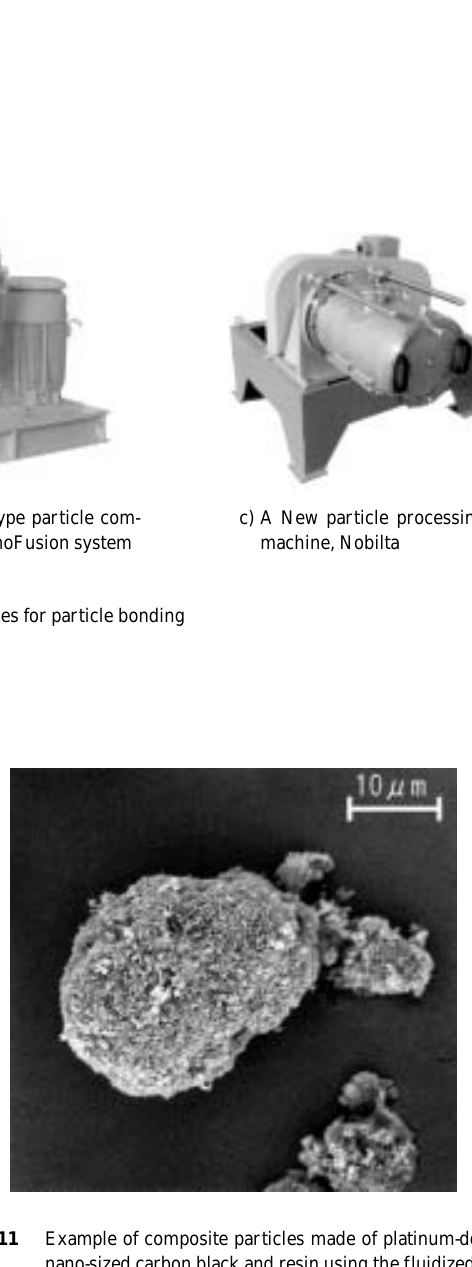
Example of composite particles made of platinum-doped nano-sized carbon black and resin using the fluidized-bed granulator (Agglomaster)